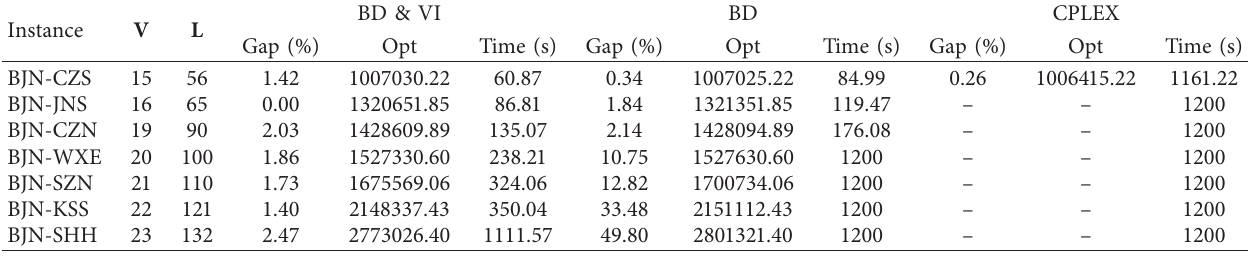
Table 4: Computational results for the instances.